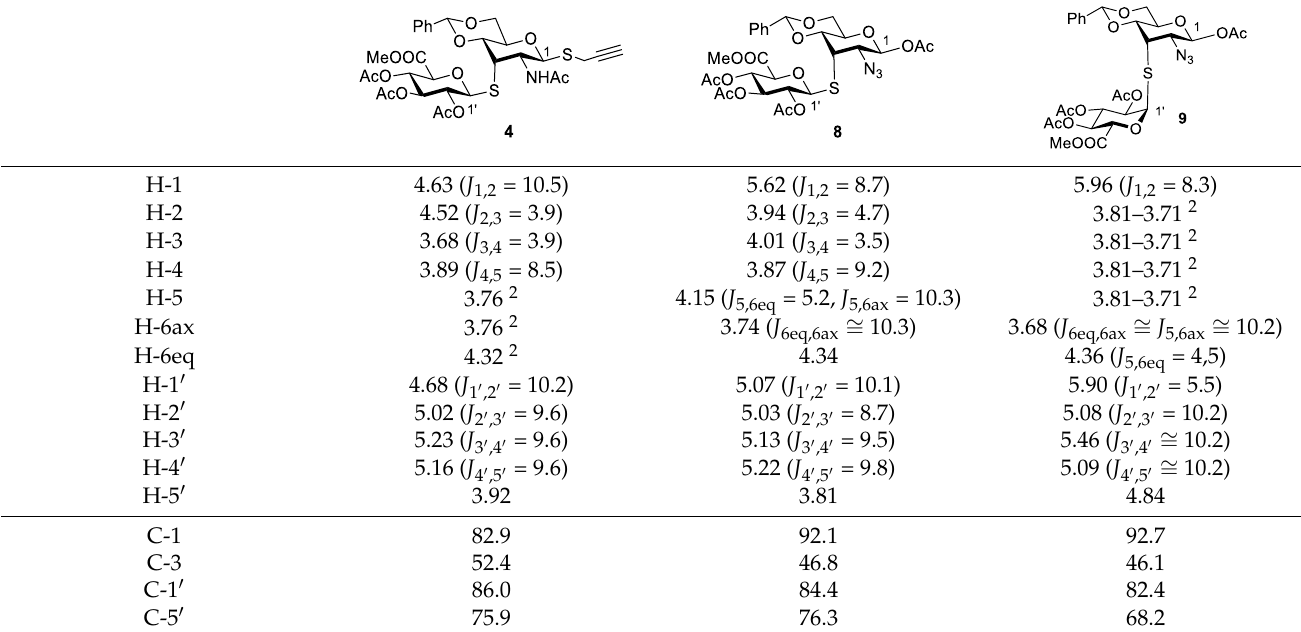
Table 1. 1 H and 13 C-NMR characteristic signals of thiodisaccharides 4 , 8 and 9 . 1